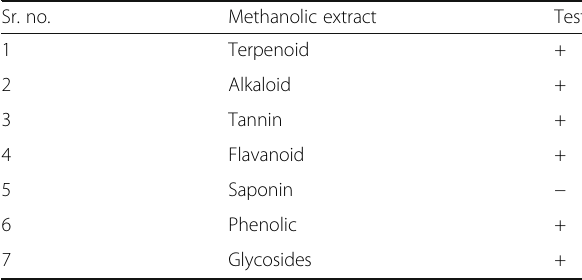
Table 2 Phytochemical constituent analysis of methanolic extract of P. fistulosus fruit Sr.